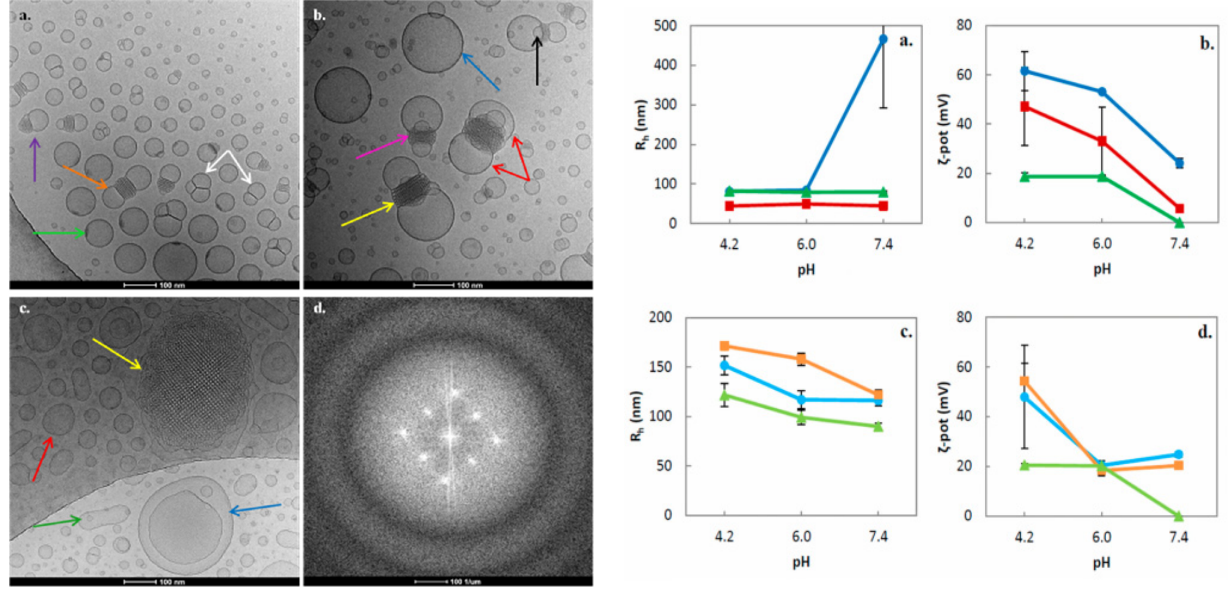
Figure 5. (Left Panel, a – d ) Cryo-TEM images of liquid crystalline nanosystems with PDMAEMA-b-PLMA. (Right Panel, a – d ) Physicochemical characteristics of the nanosystems depending on the pH of the dilution medium. Adapted by Chountoulesi et al. [38].